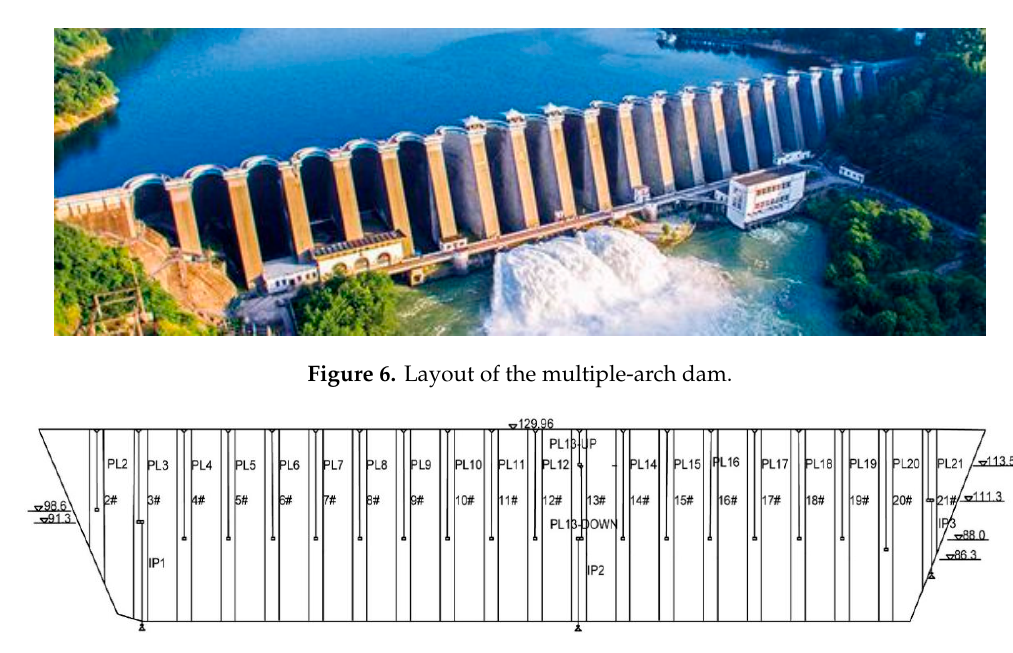
Figure 7. Pendulum systems for monitoring horizontal displacement.